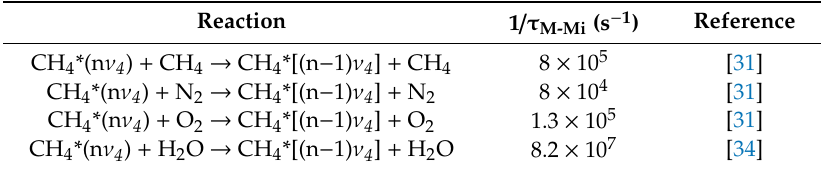
Table 1. V–T relaxation rates of the n th ν 4 CH 4 * excited vibrational state with the main collisional partners in standard air at a working pressure of 1